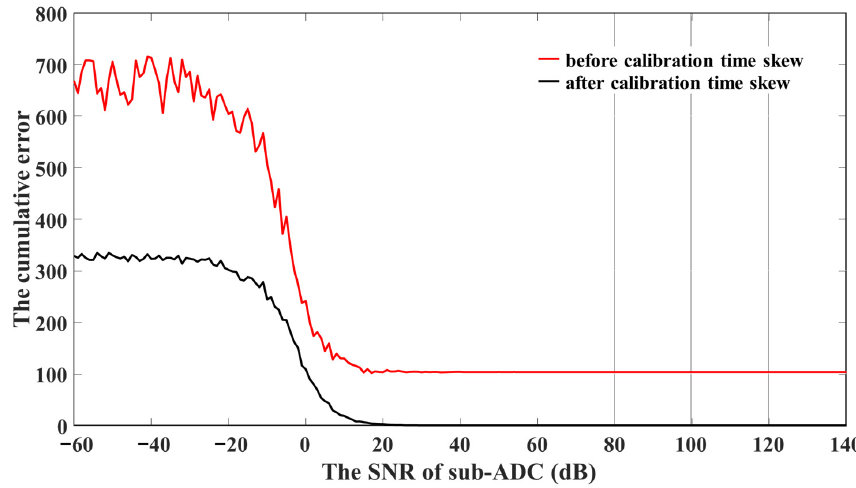
Figure 13. The cumulative errors under different SNR of the sub ‐ ADC in the proposed technique.